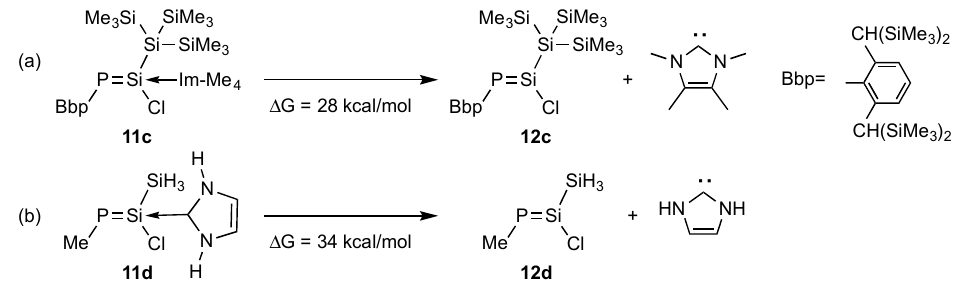
Scheme 3. Theoretical calculations of NHC-coordinated and non-coordinated phosphasilenes. ( a ) B3PW91-D3BJ/6-31+G(d,p)//B3PW91/6-31+G(d,p); ( b ) MP2/6-311G(2d).